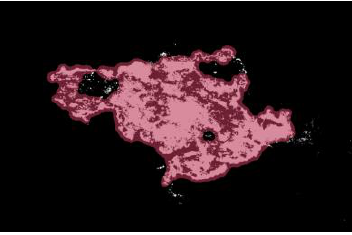
Figure 11. Morphological post-processed U-net model prediction in light red overlapped with the proposed RBR